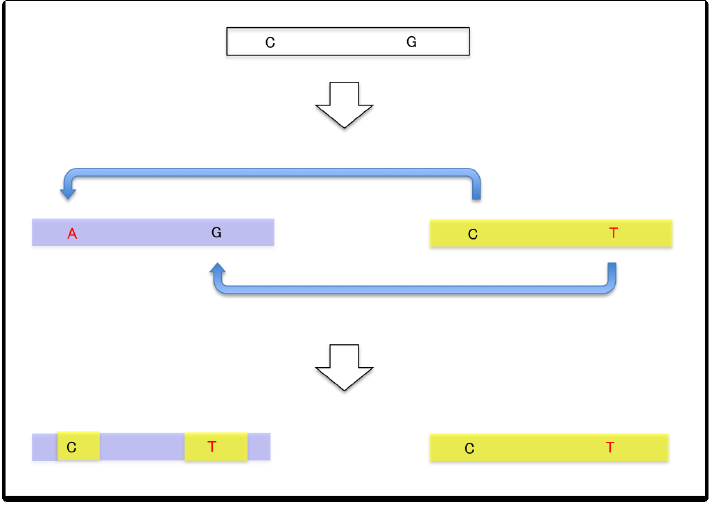
Figure 1. Simple gene conversion model for a pair of duplicated genes (or paralogous genes). Converted tracts will be pasted to the corresponding part of the paralog, while there is no change in the original gene. Conversion can result in the novel mutation (shown in red) being spread or reversed. Although converted tracts will become identical in sequence,